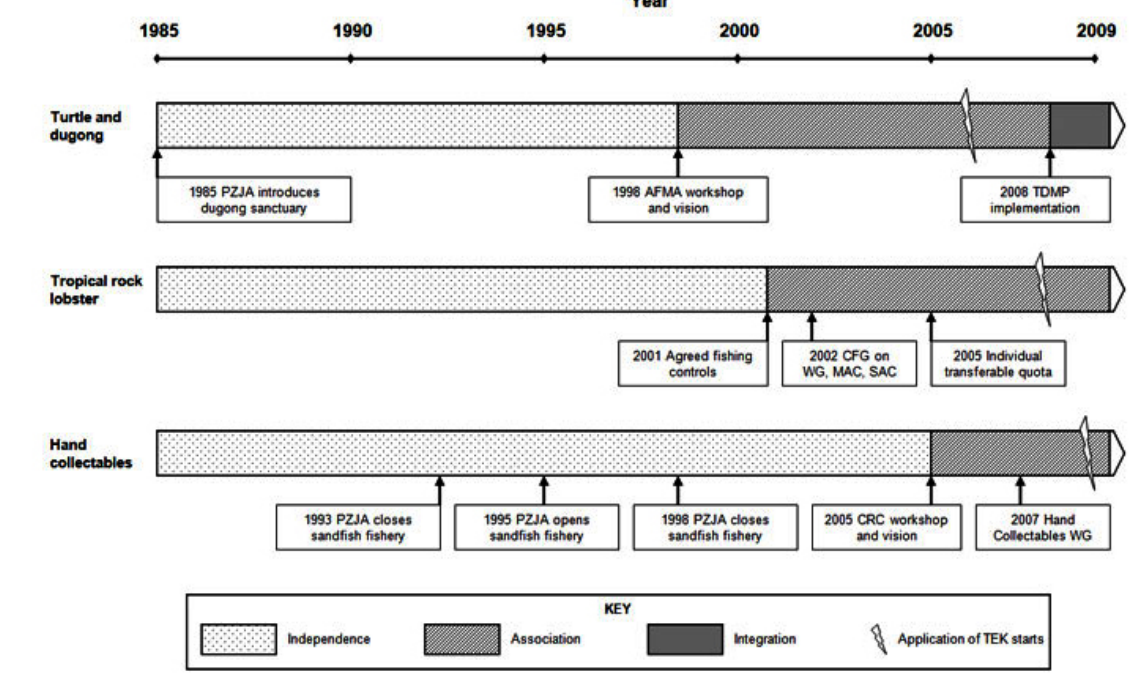
Fig. 4 . The chronology of comanagement and application of traditional ecological knowledge (TEK) in the turtle and dugong ( Dugong dugon ), lobster and hand collectable fisheries between the 1985 signing of the Torres Strait Treaty and 2009, applying Plummer’s (2006) stages of ‘independence,’ ‘association,’ and ‘integration.’ Abbreviations are: Protected Zone Joint Authority (PZJA), Australian Fisheries Management Authority (AFMA), Turtle and Dugong Management Plan (TDMP), Community Fisher Group (CFG), Working Group (WG), Management Advisory Committee (MAC), Scientific Advisory Committee (SAC), Cooperative Research Centre